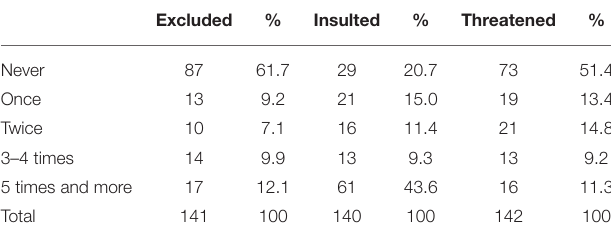
TABLE 2 | Reported school bullying.